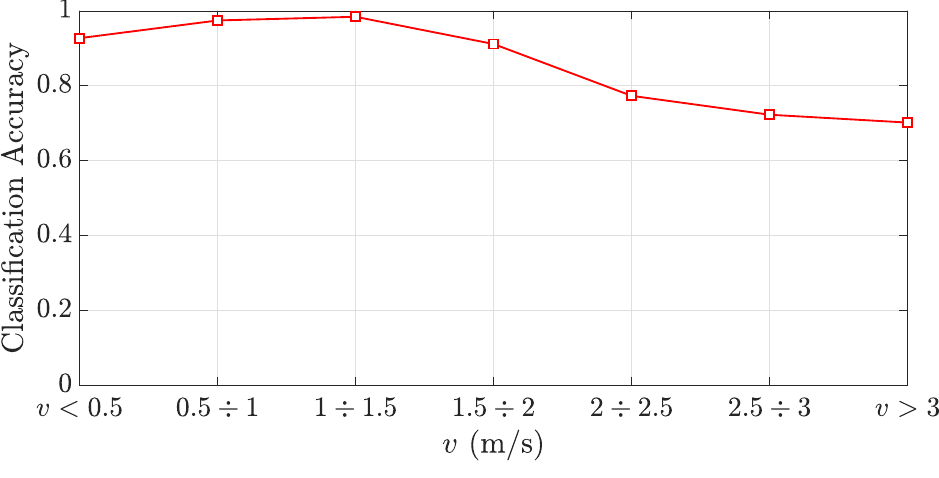
Figure 13. Classification accuracy vs. forklift speed v .